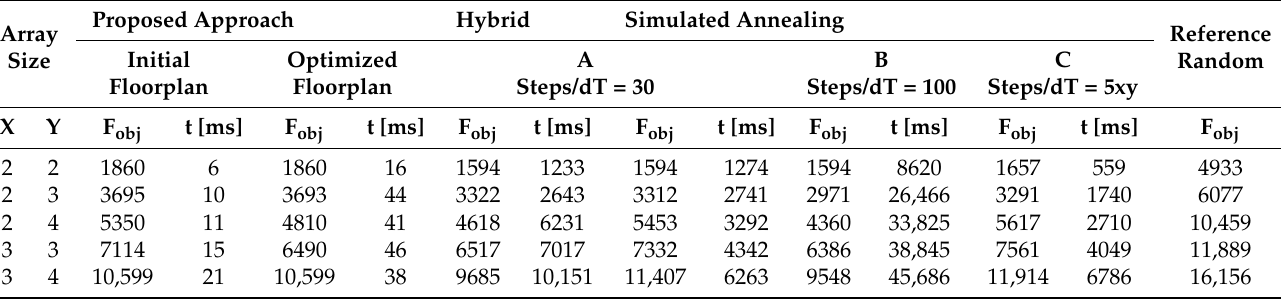
Table 1. Comparison of floorplanning methods for Artix7.